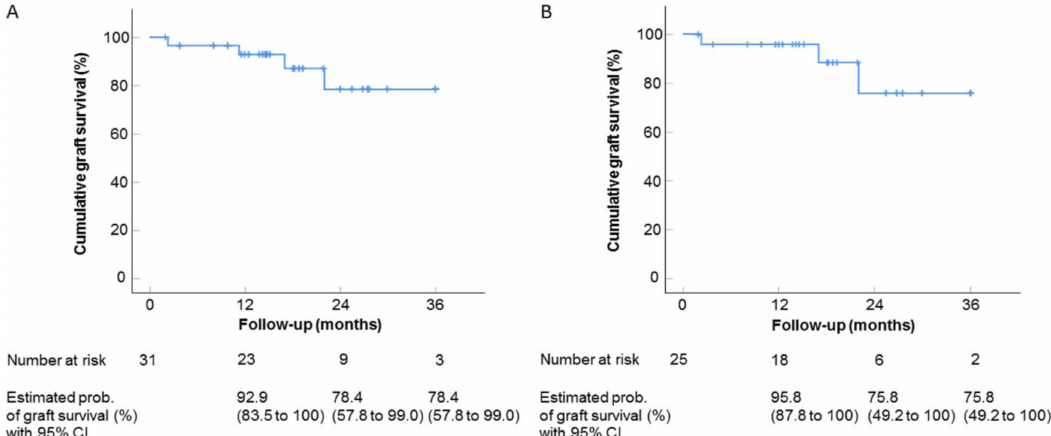
Figure 12. Impact of pre-transplant fine-needle diathermy (FND) combined with subconjunctival bevacizumab injection on corneal allograft survival after subsequent high-risk penetrating keratoplasty. Kaplan–Meier curves depicting the estimated probabilities of rejection-free corneal graft survival after penetrating keratoplasty. Estimated probabilities of rejection-free corneal graft survival were 92.9% after 1 year (number at risk: 23), 78.4% after 2 years (number at risk: 9), and 78.4% after 3 years (number at risk: 3) for all study eyes (non-HLA-matched and HLA-matched keratoplasties) ( A ) and 95.8% after 1 year (number at risk: 18), 75.8% after 2 years (number at risk: 6), and 75.8 after 3 years (number at risk: 2) for eyes only with non-HLA-7 matched keratoplasties ( B ). Mean follow-up time: 560 days; range: 59–1095 days. Vertical dashes indicate censored observations. CI, confidence interval. From Hos et al. 2019